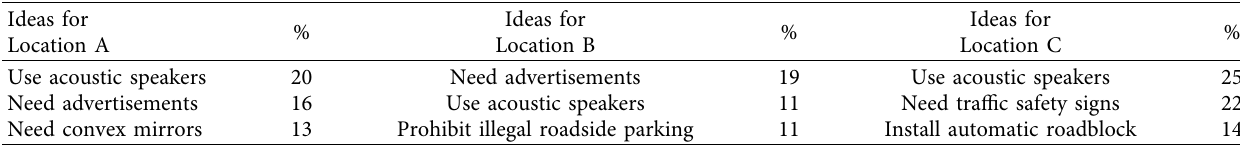
Table 6: Suggestions for improving trafc safety at each location, based on open-ended